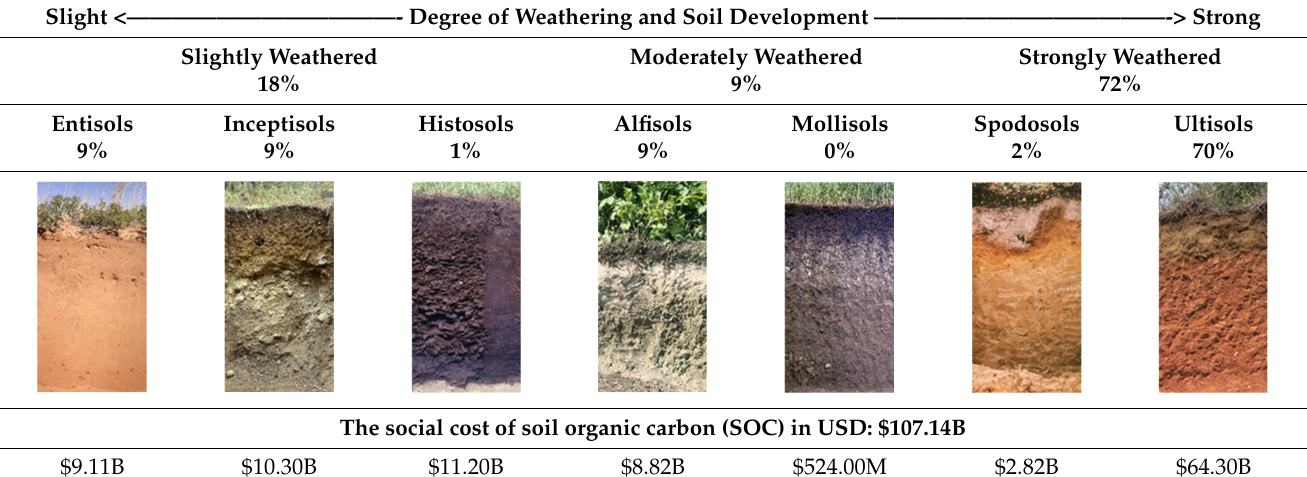
represent social costs of soil C from different point of views: “avoided” versus “realized” social costs. Soil carbon stored in the soil represents the “avoided social cost” of soil C if not converted to CO 2 and released into the atmosphere. When CO 2 is released into the atmosphere, it becomes the “realized social cost” because of the damages from global warming. In South Carolina, Histosols and Alfisols are particularly sensitive to climate change because of relatively high soil C content, which is most likely to experience higher decomposition rates due to increases in temperature and precipitation. All soils in the state of South Carolina have low recarbonization potential. Table 11. Distribution of soil carbon regulating ecosystem services in the state of South Carolina (U.S.A.) by soil order (photos courtesy of USDA/NRCS [23]) in the upper 2-m depth based on avoided or realized the social cost of CO 2 (SC-CO 2 ) of $46 (USD) per metric ton of CO 2